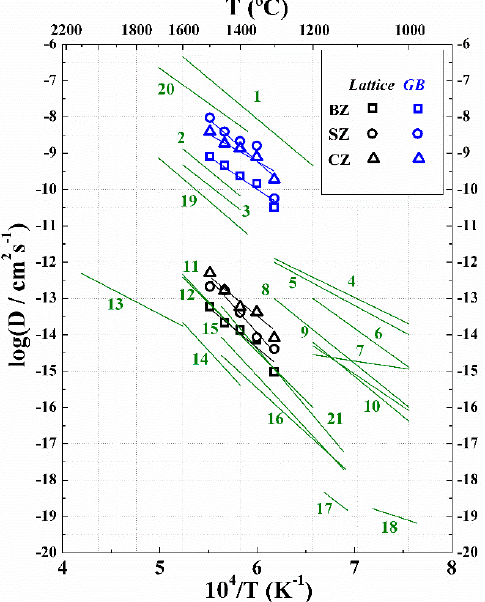
Figure 7. Zr diffusivity in AZrO 3 compared to data diffusion data in fluorites. Abbreviations: p—polycrystalline; sc—single crystal; c—cubic; t—tetragonal; b—bulk; gb—grain boundaries. (1) 96 Zr